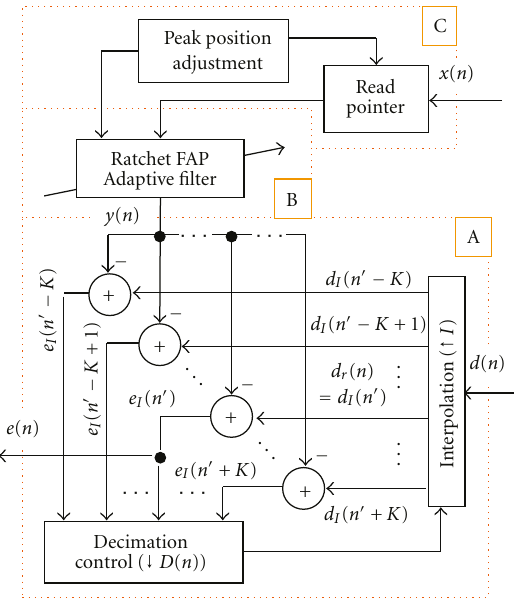
Figure 3: Proposed DCAF